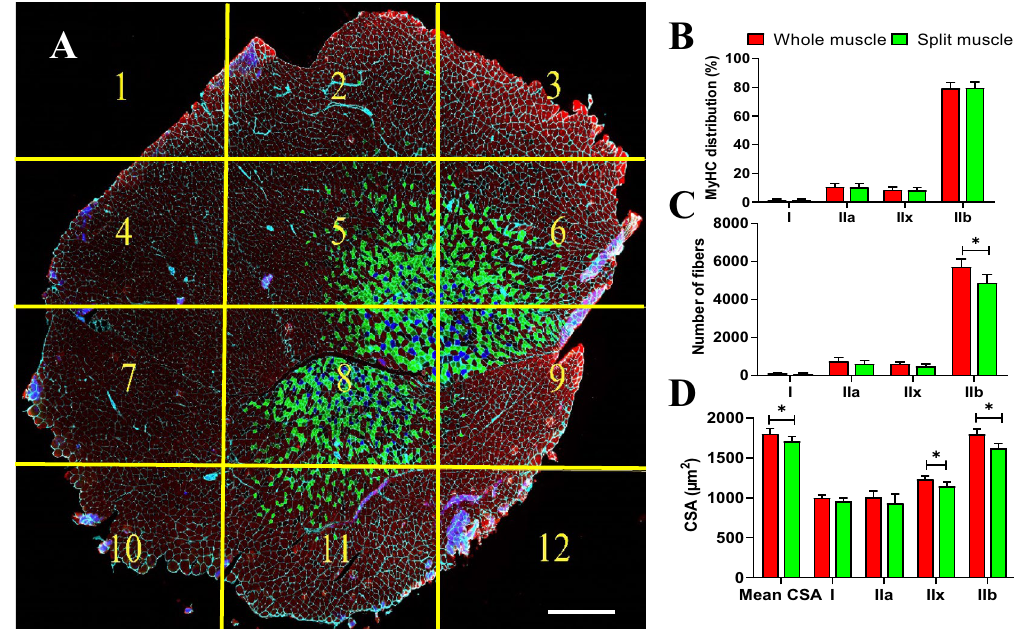
Figure 7. Whole muscle analysis for different myofiber types by MyoView. ( A ) Whole reconstitution of a MyHC I, IIa, IIx, and IIb -stained cryosection of a gastrocnemius muscle from 5 mice on 56 days post-HIIT program (12 pictures were automatically recorded and assembled by MetaMorph software (MetaMorph Microscopy Automation and Image Analysis Software, version 7.7.7.0., http:// www. molec ulard evices. com/ Produ cts/ Softw are/ Meta- Imagi ng- Series/ MetaM orph. html)). The position of each individual image is highlighted by the yellow lines. ( B ) MyHC distribution obtained after various subsettings of pictures in ( A ) as compared